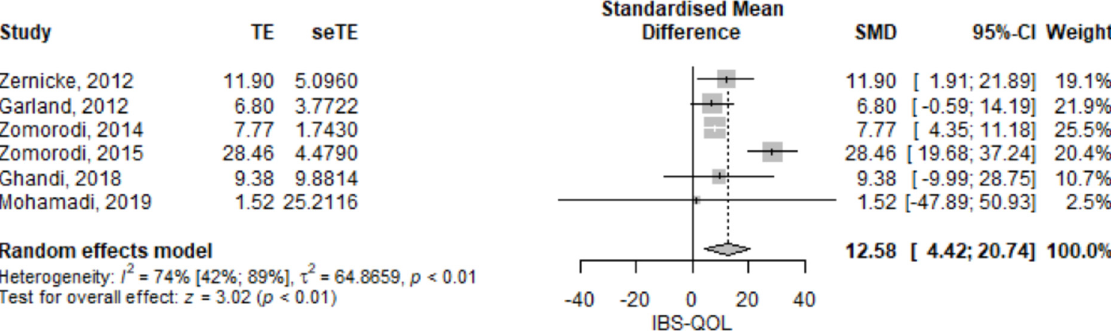
Figure 3. Irritable bowel syndrome quality of life—standardized mean difference comparison be- tween mindfulness intervention and control. IBS-QOL, irritable bowel syndrome quality of life; SMD, standardized mean difference; TE, treatment effect as SMD; seTE, standard error of the treatment effect; CI, confidence interval [15,17,18,20,21].